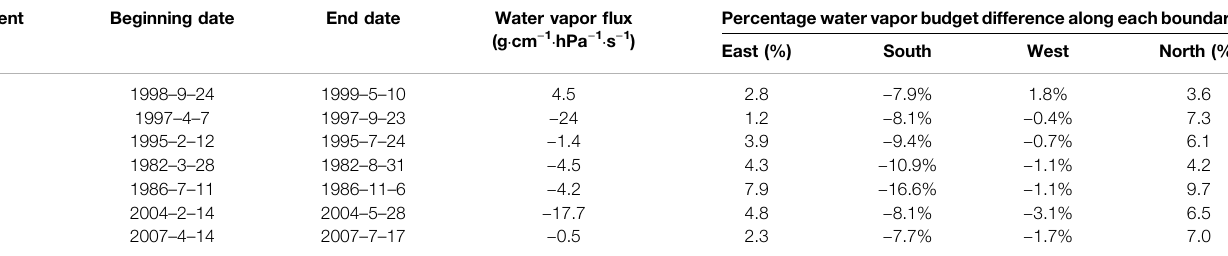
TABLE 1 | The difference in the total and four boundary water vapor fl uxes of the cross-seasonal strong drought events in the ENC.